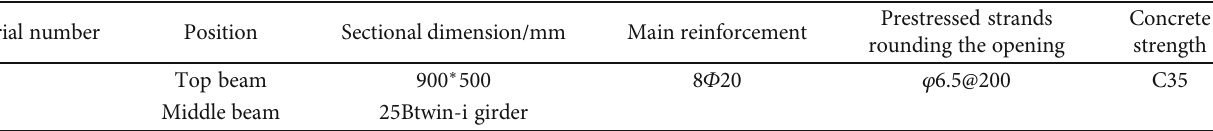
Table 4: Design parameters of the crown beam and waist